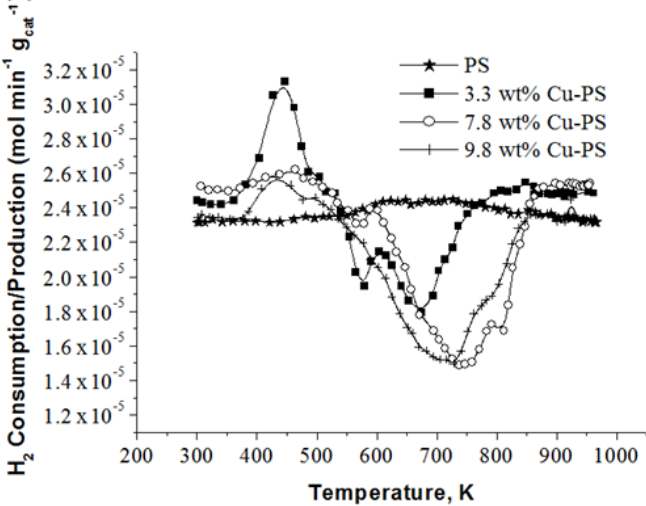
Figure 4. H 2 -temperature program reduction (TPR) profiles of the PS and various wt% of Cu-PS powder samples.